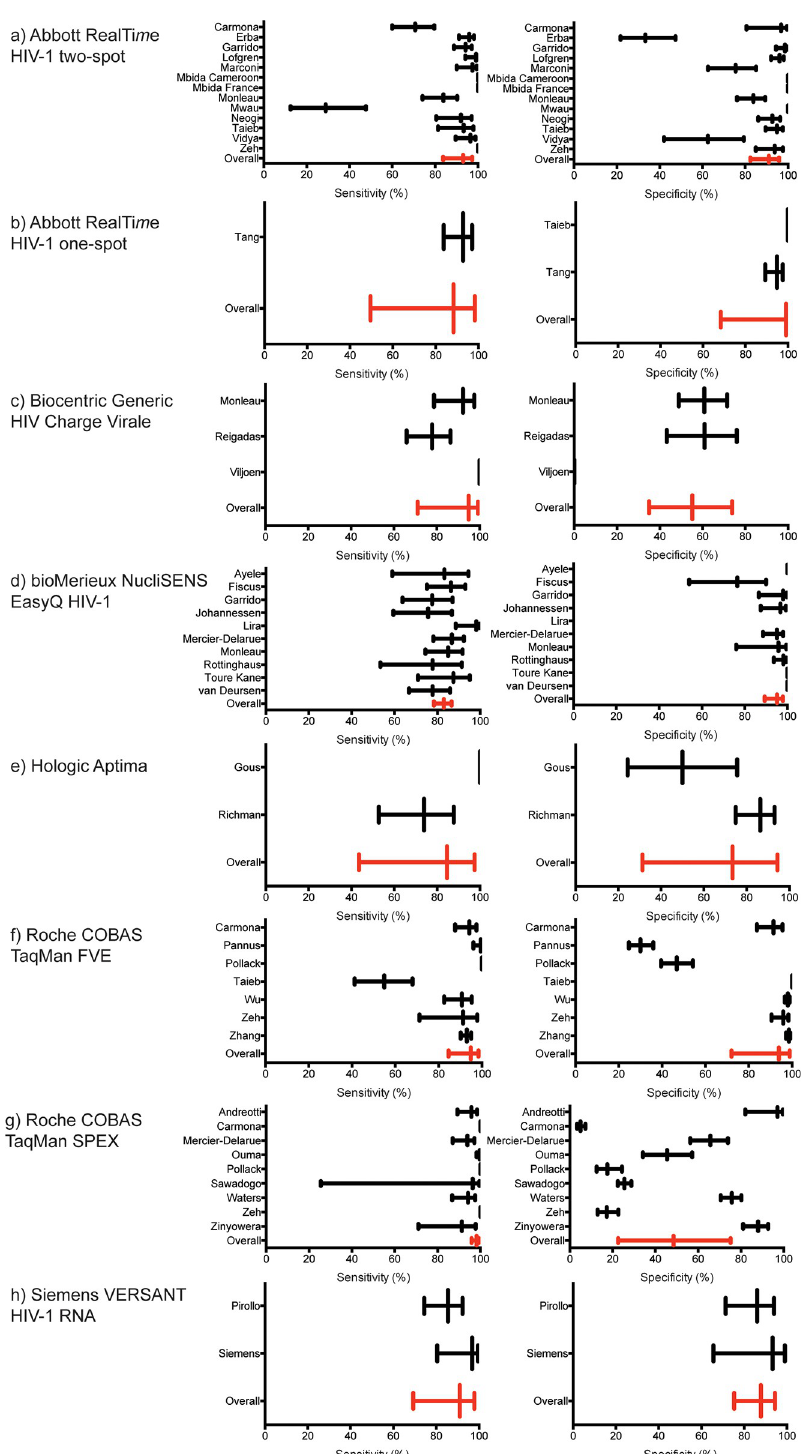
Fig 3. Forest plots of sensitivity and specificity of all studies included in the meta-analysis for each viral load technology using a treatment failure threshold of 1,000 copies/ml. Abbott RealTi m e HIV-1 two-spot (a), Abbott RealTi m e HIV-1 one-spot (b), Biocentric Generic HIV Charge Virale (c), bioMerieux NucliSENS EasyQ HIV-1 (d), Hologic Aptima (e), Roche COBAS TaqMan FVE (f), Roche COBAS TaqMan SPEX (g), Siemens VERSANT HIV-1 RNA (h). Red bars and lines indicate the overall metrics for each viral load technology.